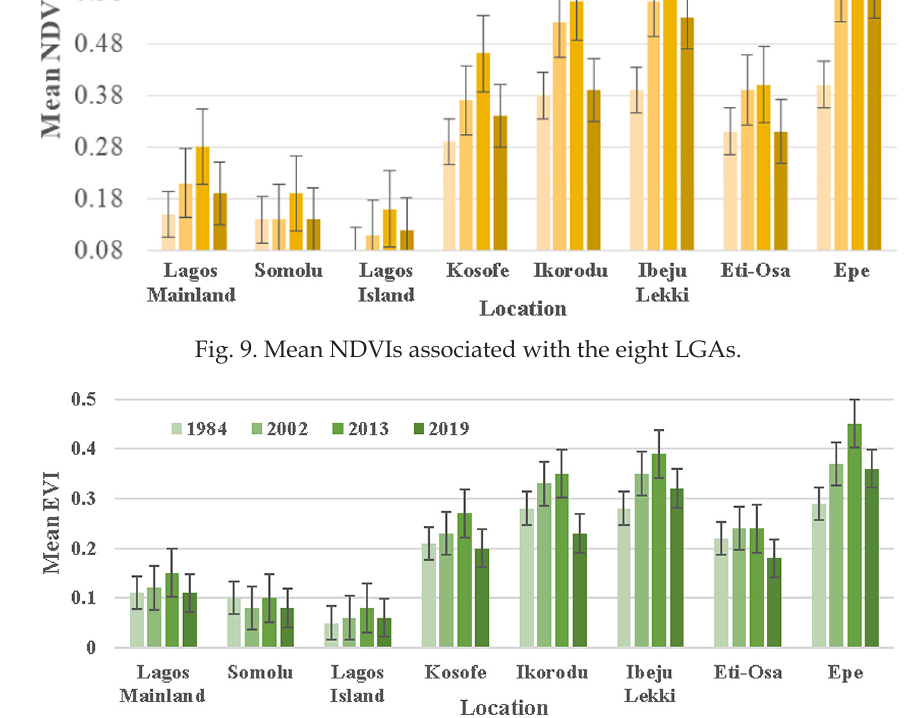
Fig. 10. Mean EVIs associated with the eight